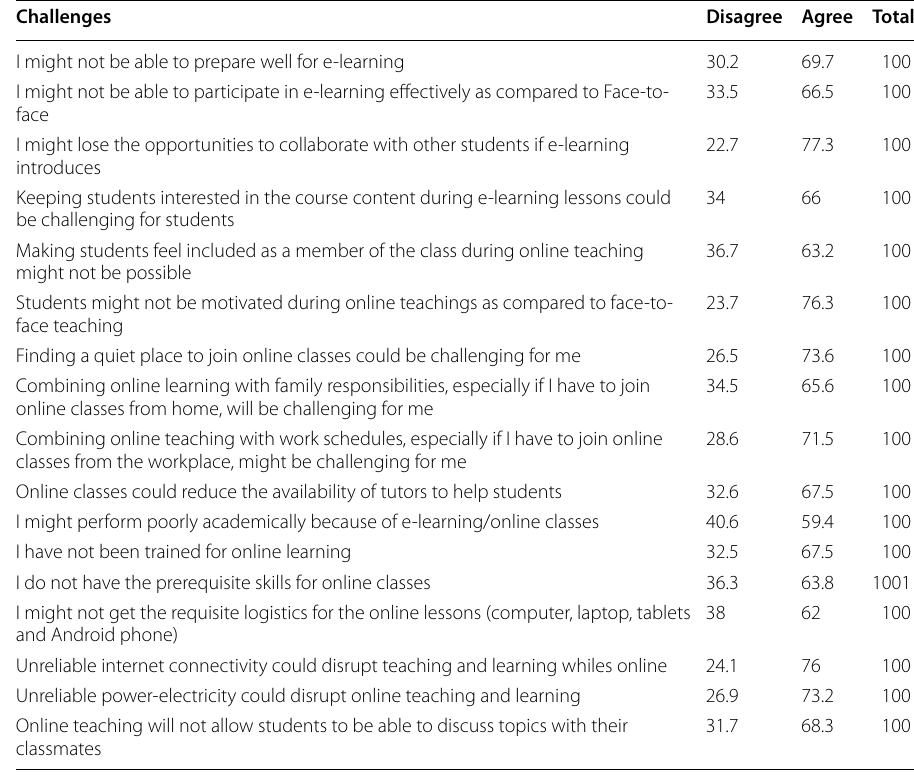
Table 6 Challenges associated with online learning. Source: Field survey (2021) Challenges Disagree Agree